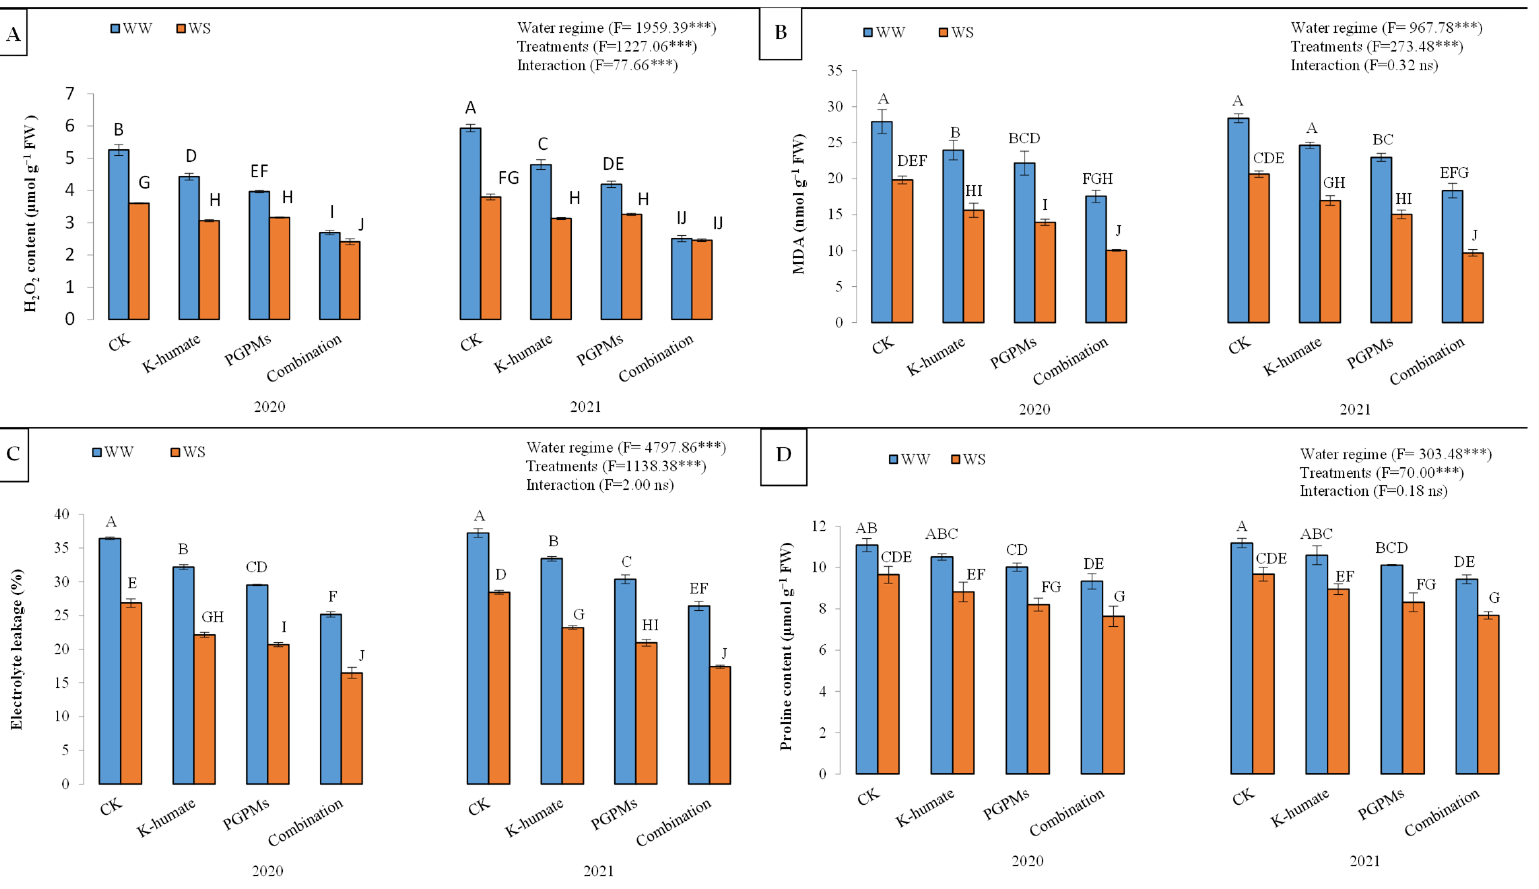
Figure 3. Variations in ( A ) H 2 O 2 content; ( B ) malondialdehyde (MDA) content; ( C ) electrolyte leakage (EL), and ( D ) proline content in soybean seeds ( Glycine max L. cv. Giza 111) leaves, which was cultivated in salt-affected soil and treated with plant growth-promoting microbes (PGPMs; Bradyrhizobium japonicum (USDA 110) and Trichoderma harzianum ), potassium humate (K-humate), and their combination under two water regimes (WS: water deficit regime and WW: well-watered regime) during two consecutive seasons. Different letters above columns show significant differences between treatments according to the Tukey’s test ( p ≤ 0.05). Data are Means ± SD and n = 3. *** denotes significance at p ≤ 0.001, ns denotes insignificant difference.